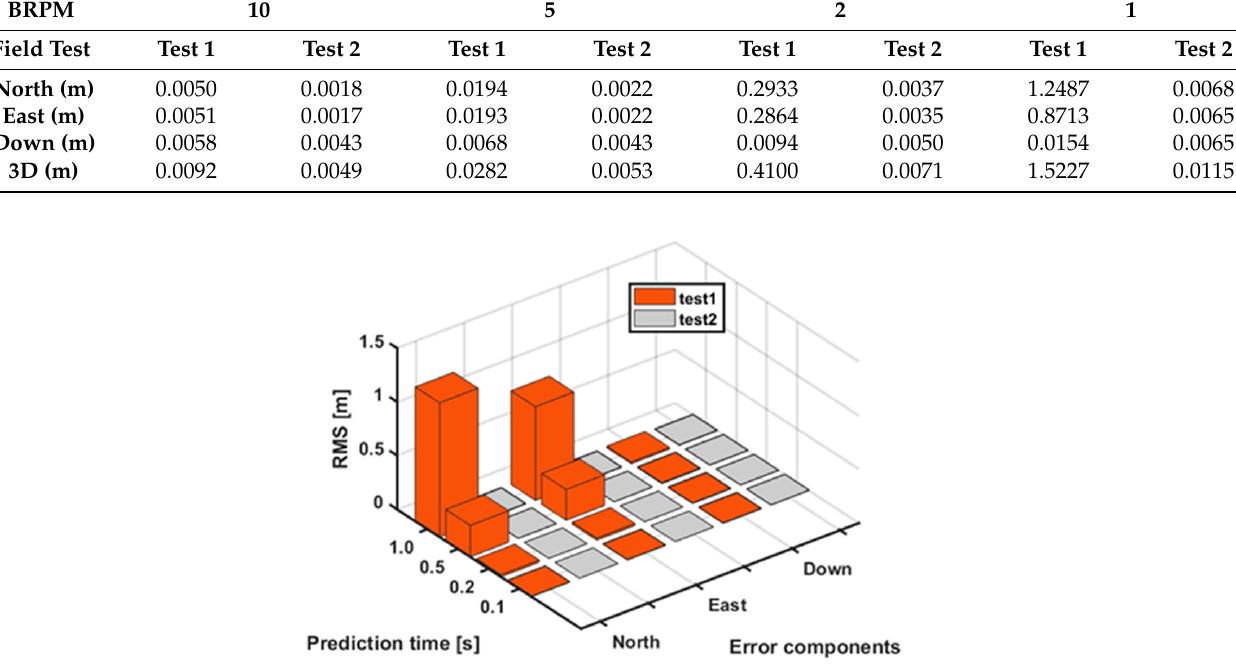
Figure 14. Comparison of position prediction errors in two tests.